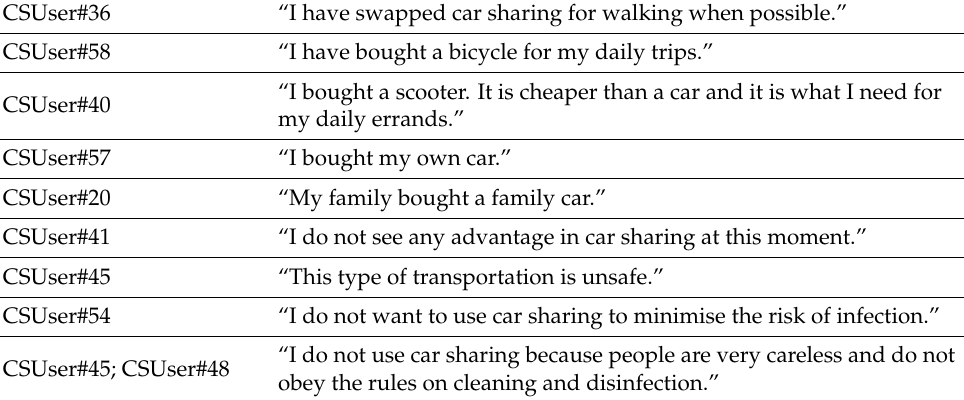
Table 6. Fearful profile